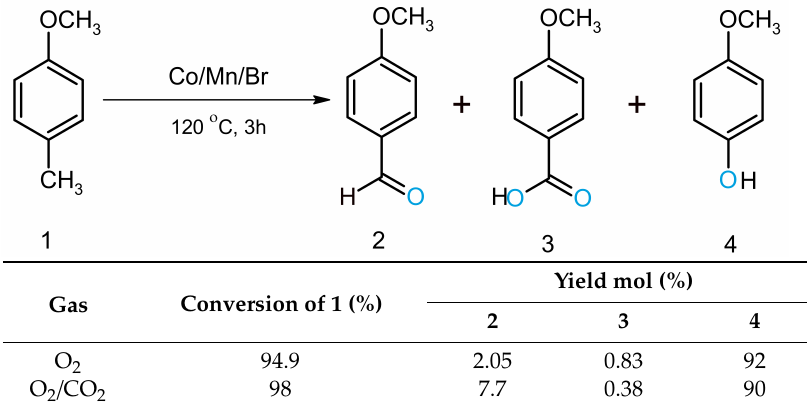
Table 6. Performance of CO 2 on oxidation of p -methylanisole (Reproduced from [22]; copyright (2012), Royal Society of